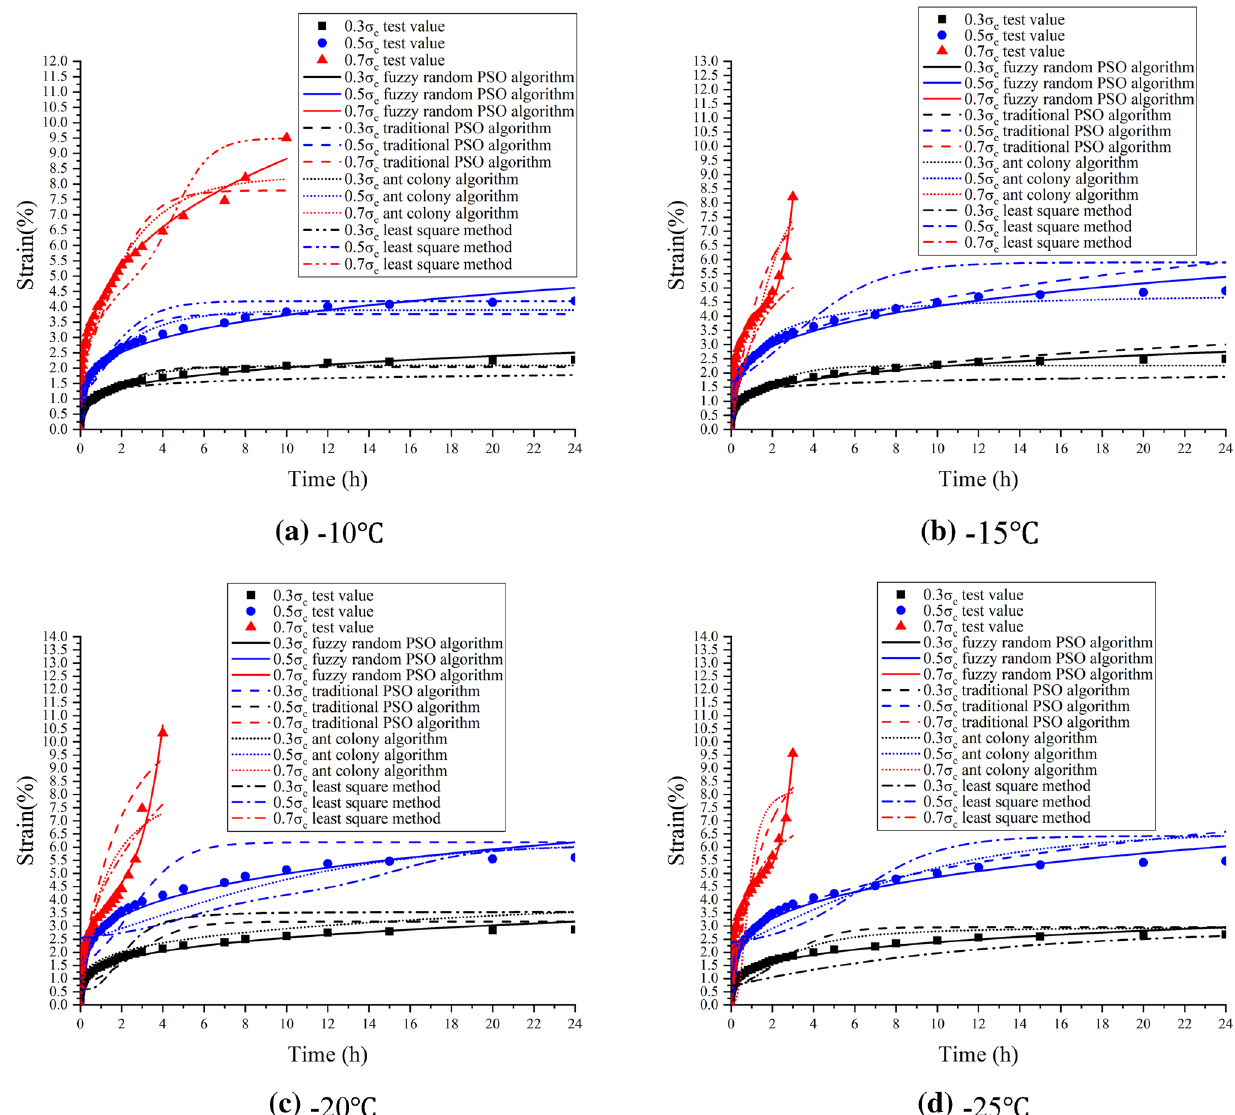
Figure 5. Comparison of least square method, ant colony algorithm, traditional particle swarm algorithm, fuzzy random particle swarm algorithm with experimental